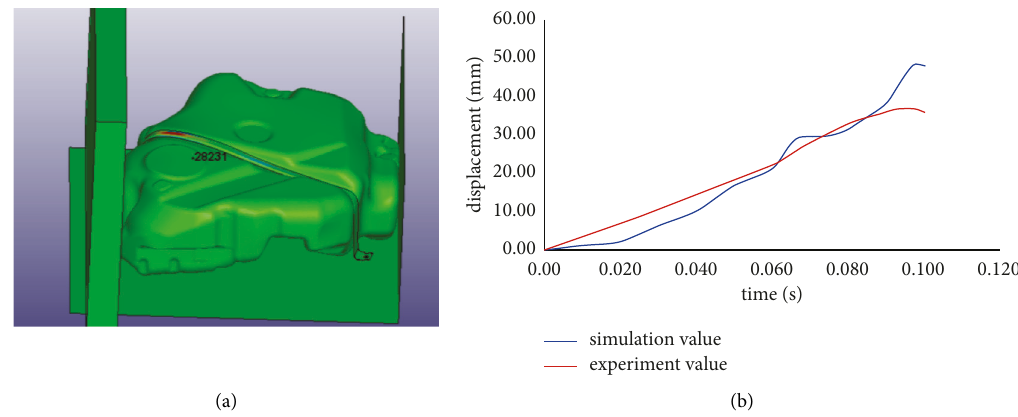
Figure 4: Fuel tank configuration and stress-strain diagram. (a) Test point. (b) X displacement of test